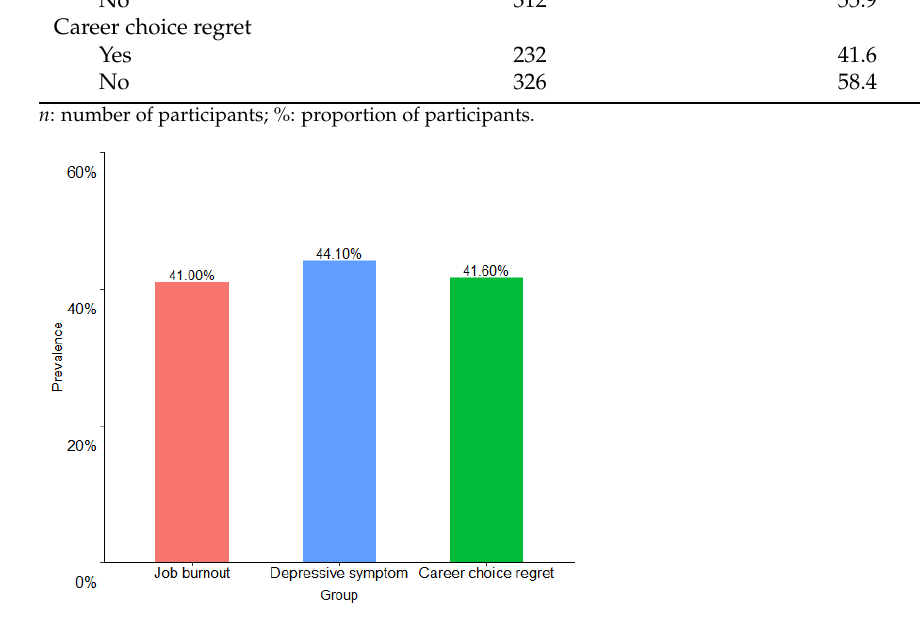
Figure 1. Prevalence of job burnout, depressive symptoms, and career choice regret. Univariate analysis showed that the factors associated with job burnout included the time worked/studied per week ( p = 0.011) and daily hours of sleep ( p < 0.001). With regards to depressive symptoms, the factors were daily hours of sleep ( p = 0.012). Regarding career choice regret, the factors were gender ( p = 0.007), postgraduate entrance examination score ( p = 0.017), and daily hours of sleep ( p < 0.001). The daily hours of sleep were the common influencing factor for job burnout, depressive symptoms, and career choice regret (Table 3). Table 3. Univariate analysis of job burnout, depressive symptoms, and career choice regret. Variables